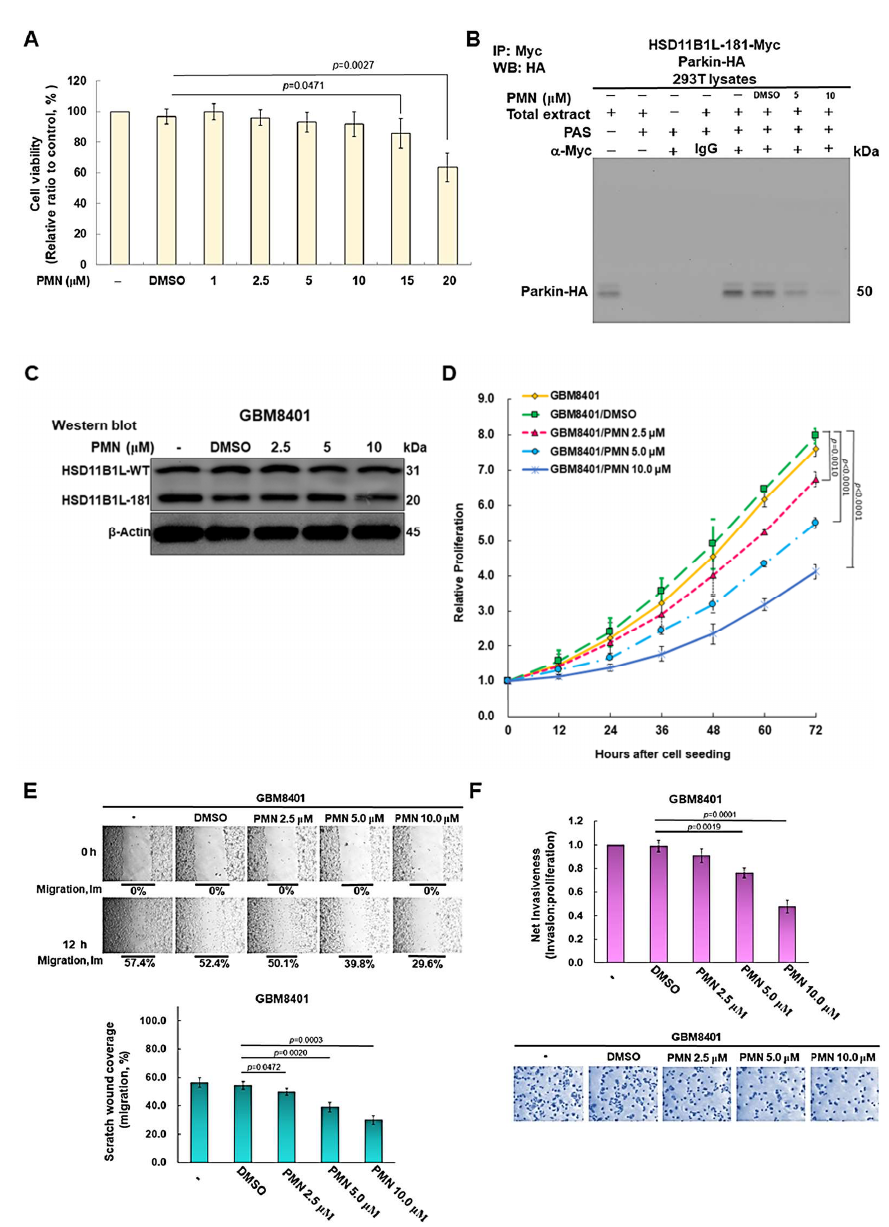
Figure 8. The proliferation, migration and invasion abilities of GBM cells were reduced by PMN treatment. ( A ) TUNEL assay was used to evaluate the cell viability of GBM8401 cells treated with different concentrations of PMN after 24 h. Results showed that cell survival was not affected at treatment concentrations below 10 µM PMN. ( B ) PMN inhibits the interaction of HSD11B1L-181